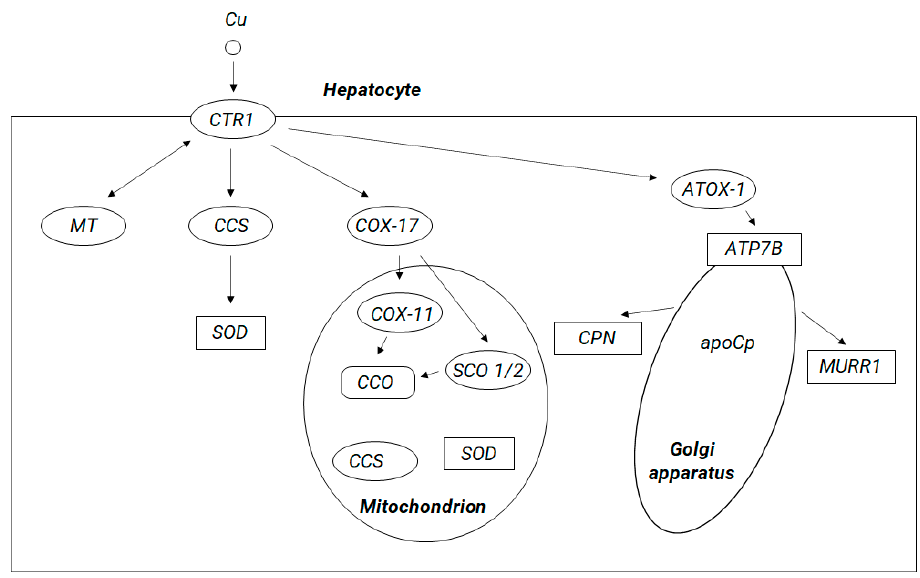
Figure 1. Copper transport paths ([39] with modifications).